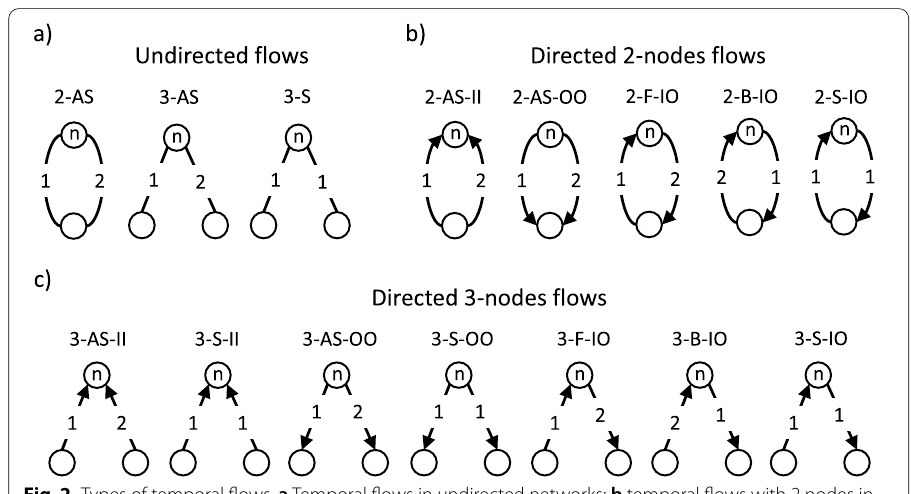
Fig. 2 Types of temporal flows. a Temporal flows in undirected networks; b temporal flows with 2 nodes in directed networks; c temporal flows with 3 nodes in directed